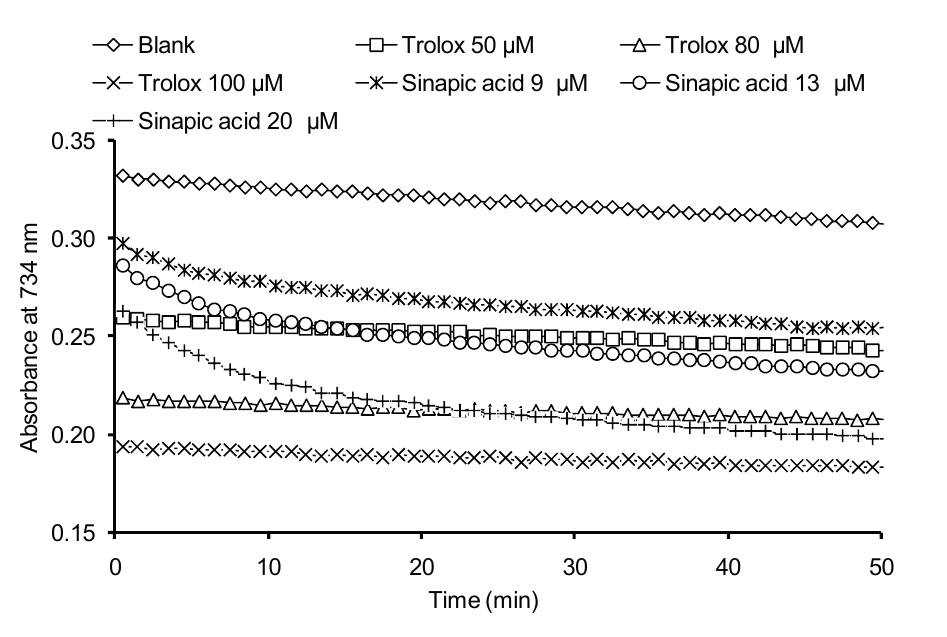
Figure 2. Kinetic curves describing the optical density decrease at interaction of the ABTS radical cation solution with various